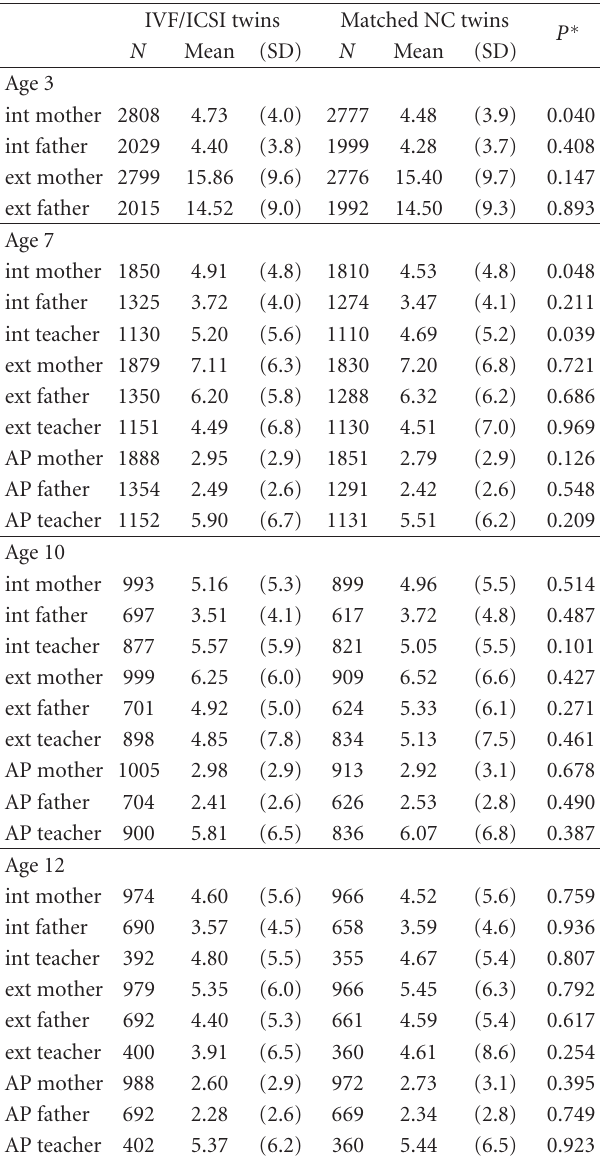
Table 5: Number, mean and standard deviation (SD) for inter- nalizing problems (int), externalizing problems (ext) and attention problems (AP) at age 3, 7, 10, and 12 years by rater (mother, father, teacher) for IVF/ICSI twins and matched NC